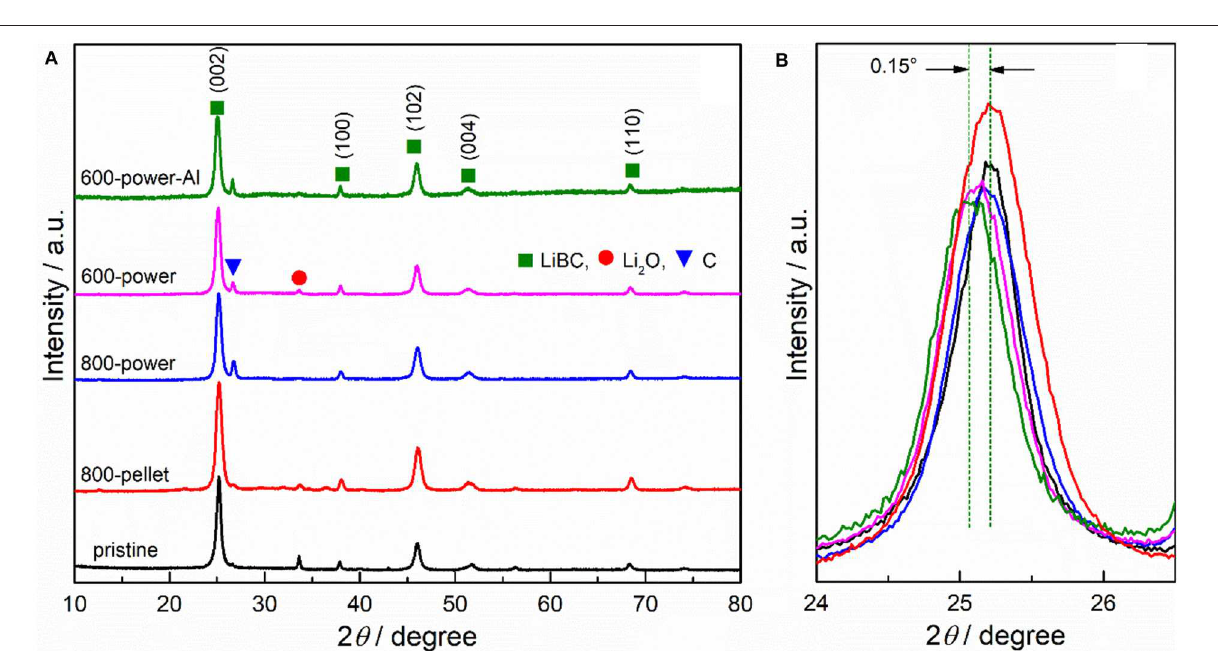
Frontiers in Energy Research |